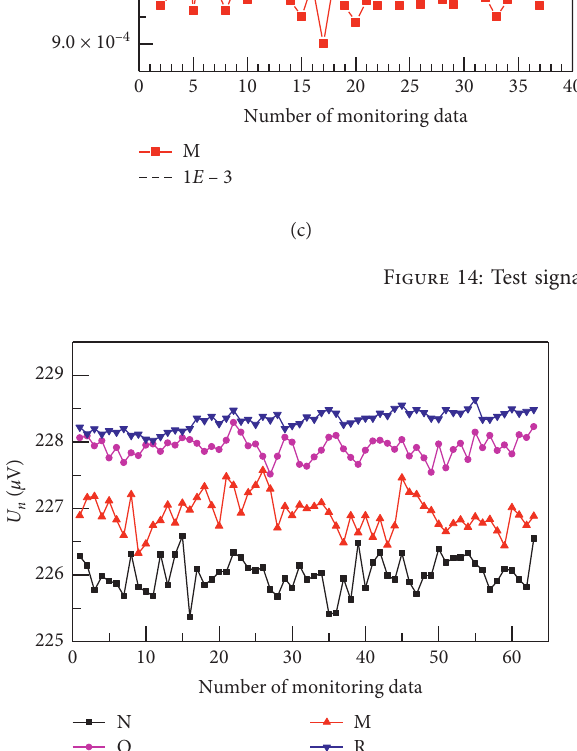
Figure 15: Test signal for measurability.